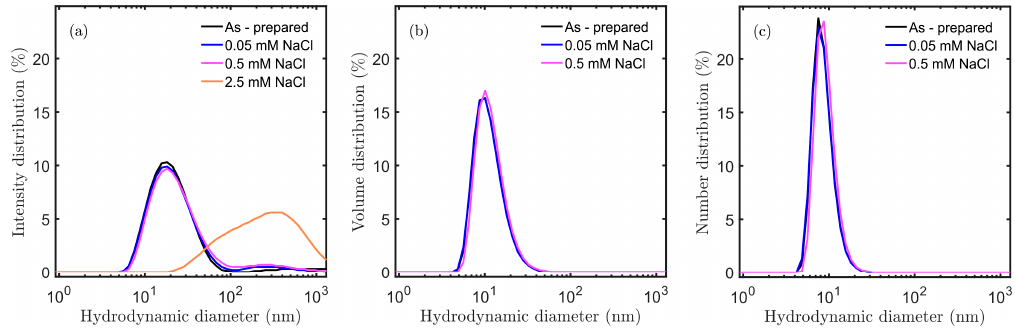
Figure 5. Particle size distributions (PSDs) measured with dynamic light scattering (DLS) before hydrothermal treatment. ( a ) Size distribution by intensity; ( b ) Size distribution by volume; ( c ) Size distribution by numbers.